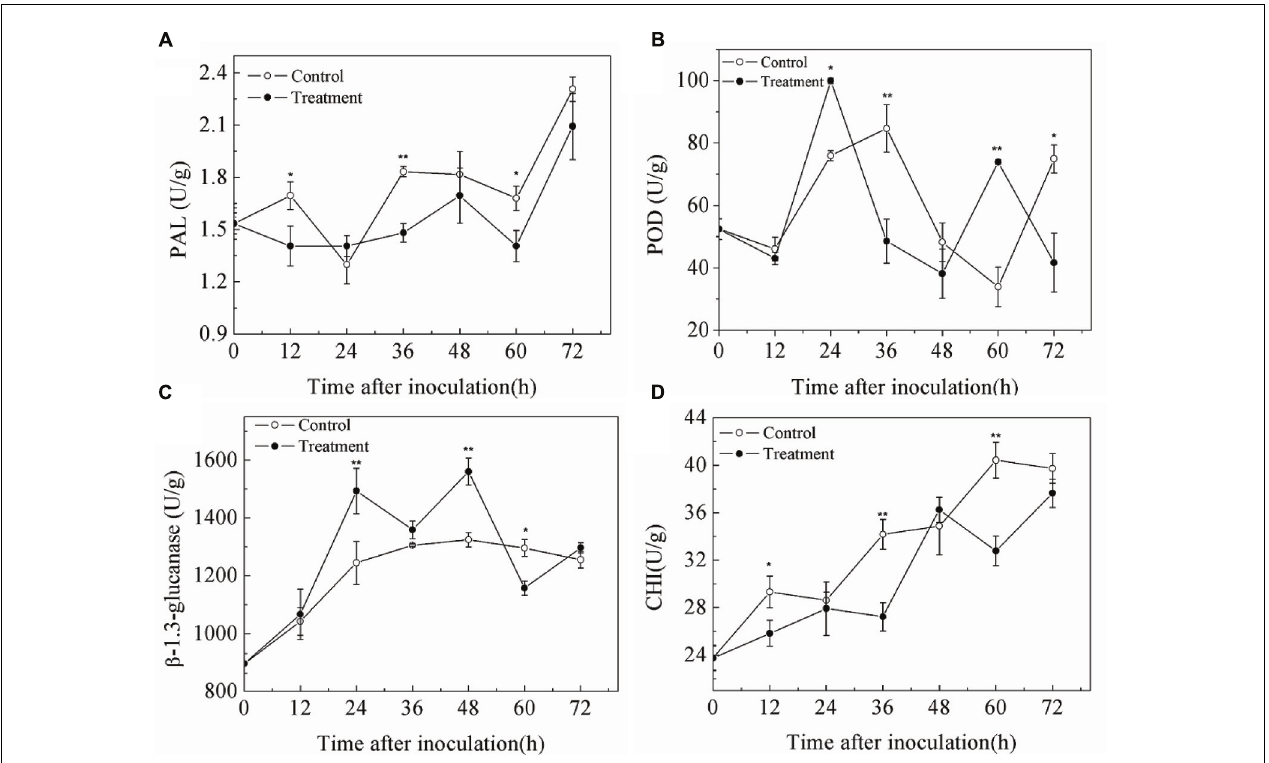
FIGURE 6 | Effect of SCLEO treatment on phenylalanin ammonia-lyase (PAL) (A), polyphenol oxidase (POD) (B), β -1,3-glutamate (C), and chitinase (CHI) (D) activities of strawberries inoculated with B. cinerea . Vertical bars represent the SD of the means. ∗ P < 0.05, ∗∗ P < 0.01 based on Tukey’s HSD between control and treated samples at each time